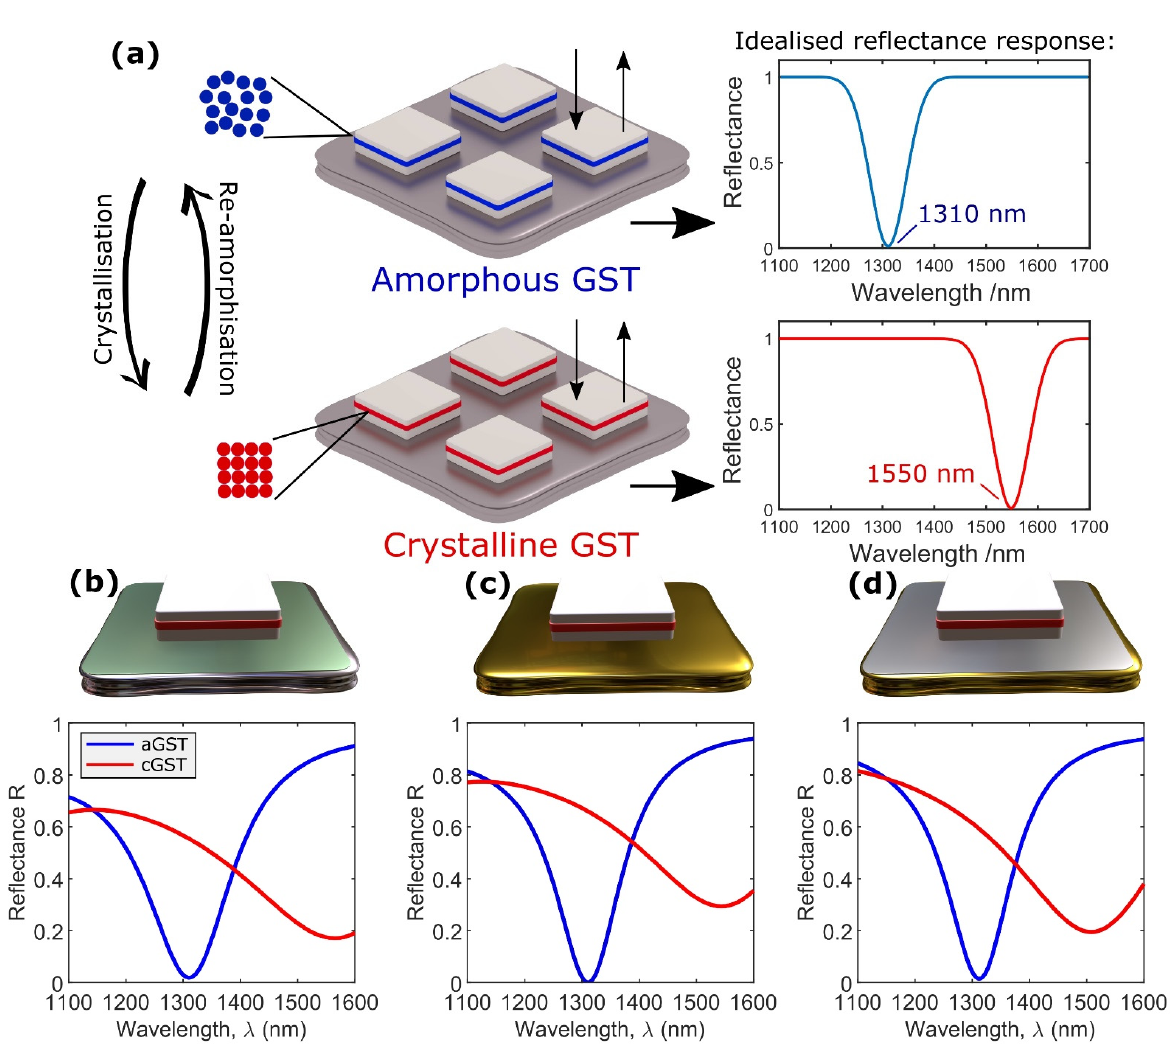
Figure 3. ( a ) Concept of device operation showing idealized reflectance spectra in amorphous and crystalline states. ( b – d ) Simulated amorphous and crystalline reflectance spectra for optimized device dimensions: ( b ) Al/Al 2 O 3 bottom plane (Design 1), ( c ) Au bottom plane (Design 2), and ( d ) Au/Si 3 N 4 bottom plane (Design 3). Table 1. Optimized device dimensions and modulation depth of three considered designs.